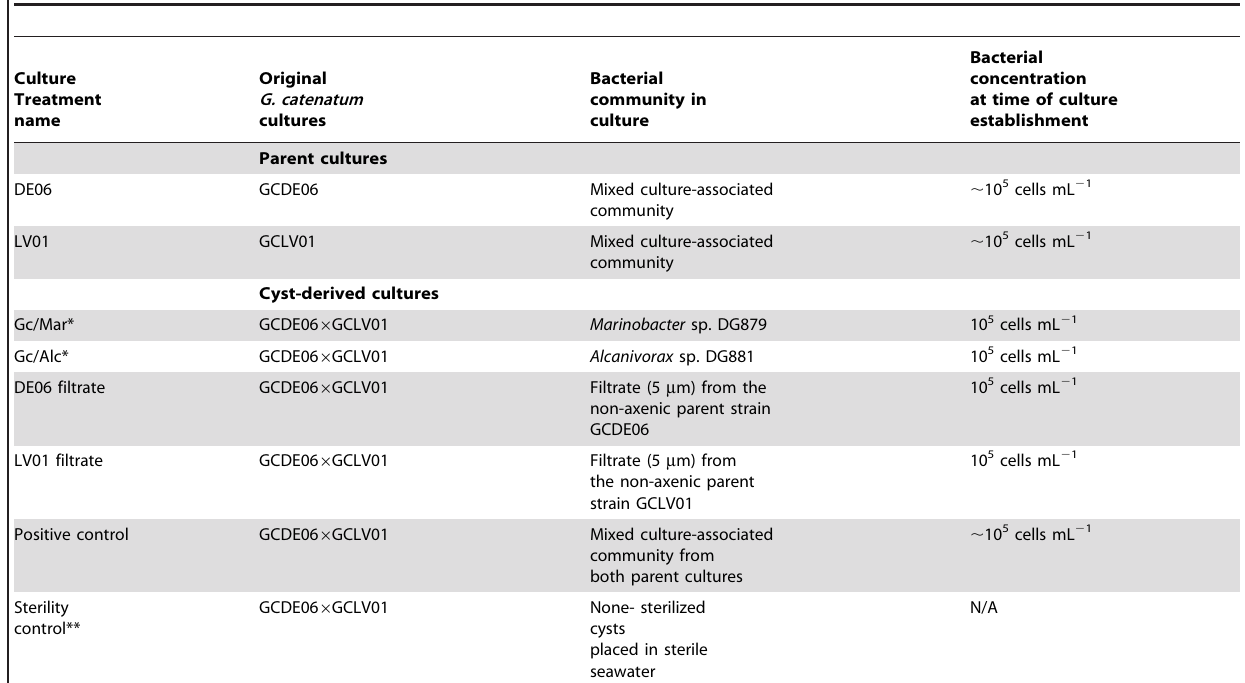
Table 1. Summary of established G. catenatum cultures used in this study.